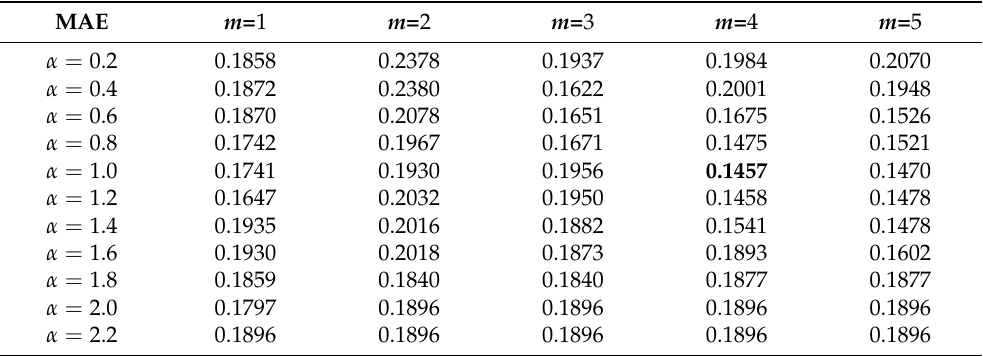
Table 2. MAE of the training dataset with different parameter combination. Bold shows the optimal